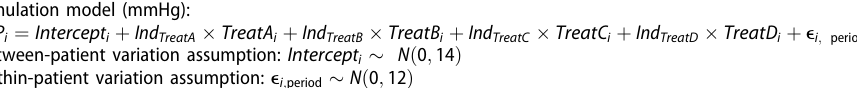
Table 5. Summary of power